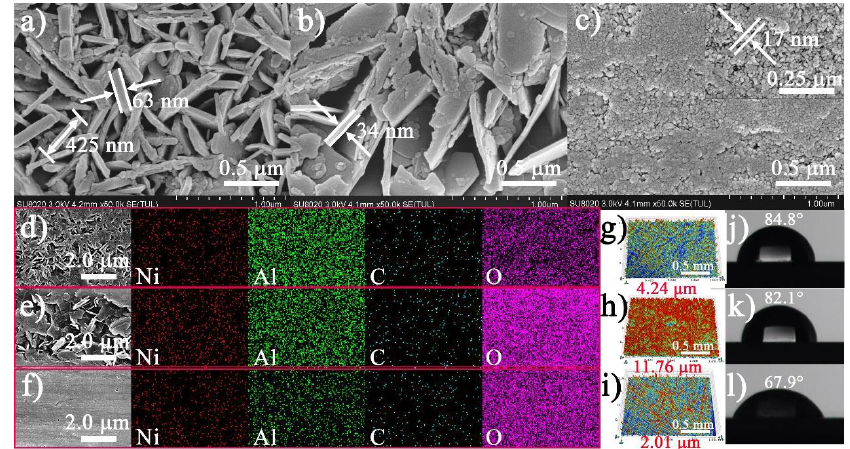
Figure 4. ( a – c ) SEM; ( d – f ) SEM-EDS mapping; and ( g – i ) 3D roughness images of the surface morphologies; and ( j – l ) water contact angles for ( a , d , g , j ) NiAl-LDH/CT, ( b , e , h , k ) NiAl-LDH/NT, and ( c , f , i , l ) NiAl-LDH/ST coatings.